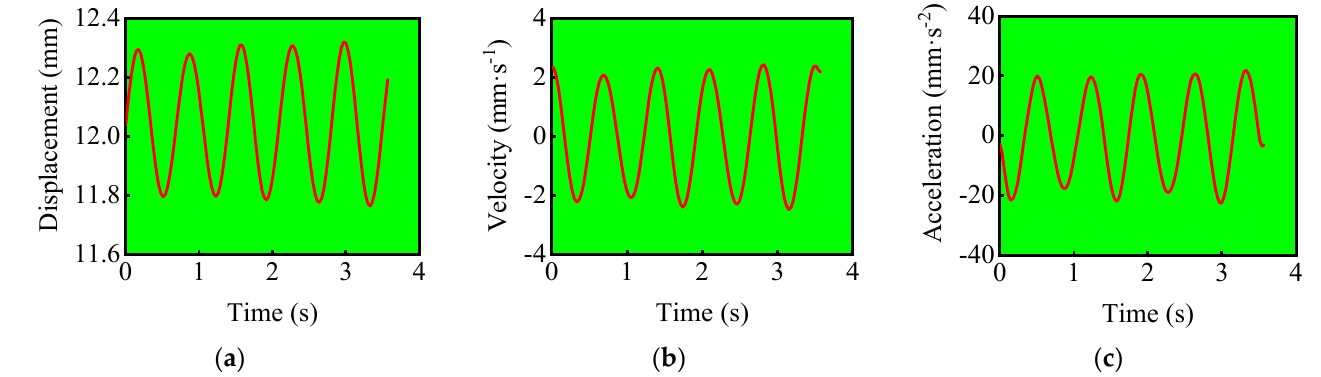
Figure 13. Typical time − history curve ( a ) displacement, ( b ) velocity, and ( c ) acceleration.